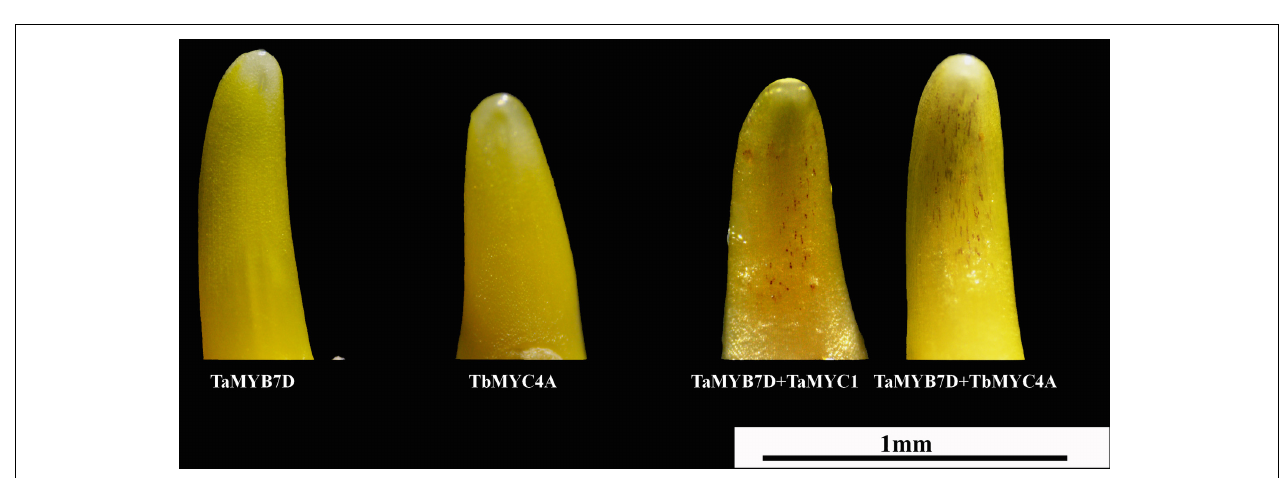
FIGURE 4 | Wheat coleoptiles 16 h after bombardment with different plasmids. TaMYB7D , TbMYC4A , and TaMYC1 represent the constructed vectors pBRACT214:TaMYB7D, pLGY-02: TbMYC4A, and pBRACT214:TaMYC1, respectively.